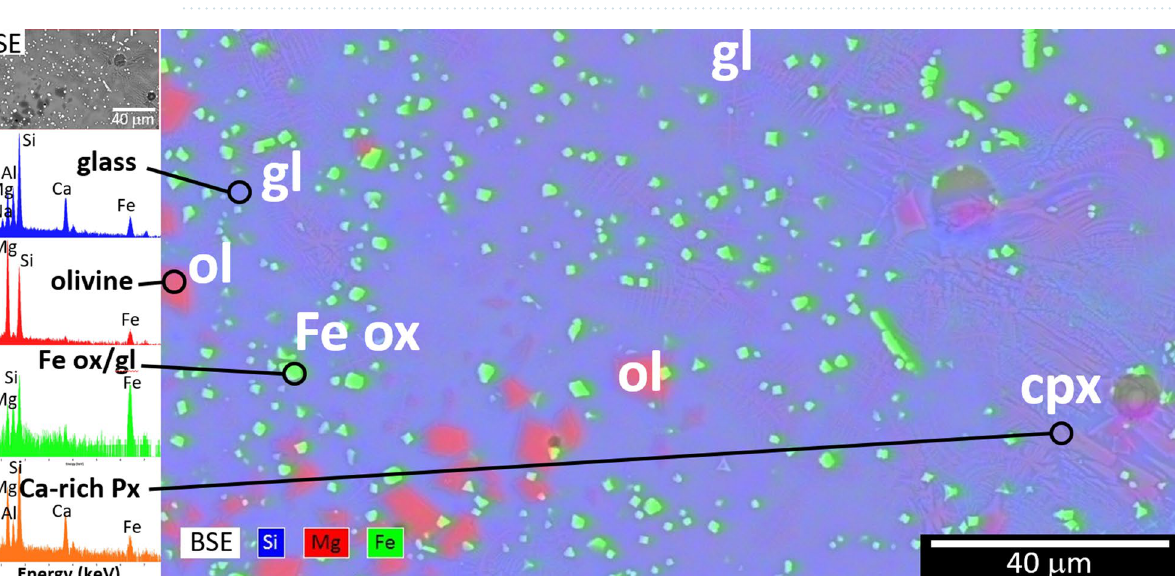
Figure 7. Microstructure and chemistry of heated amphibolite BA3 (1200-P-L-Q condition: rock chunk heated to 1200 °C in Pt, held 15 min then quenched in air). SEM-BSE image, superimposed false color X-ray map, and spectra for each chemical phase derived from the image (Al-red; Fe-green; Si-blue; P-yellow; Mg-orange). Micrometer-scale Fe oxides precipitated from the melt while all other solids represent incompletely melted minerals. Phase fractions determined by XRD (wt%): 63% glass, 2% feldspars, 8% quartz, 7% magnetite.